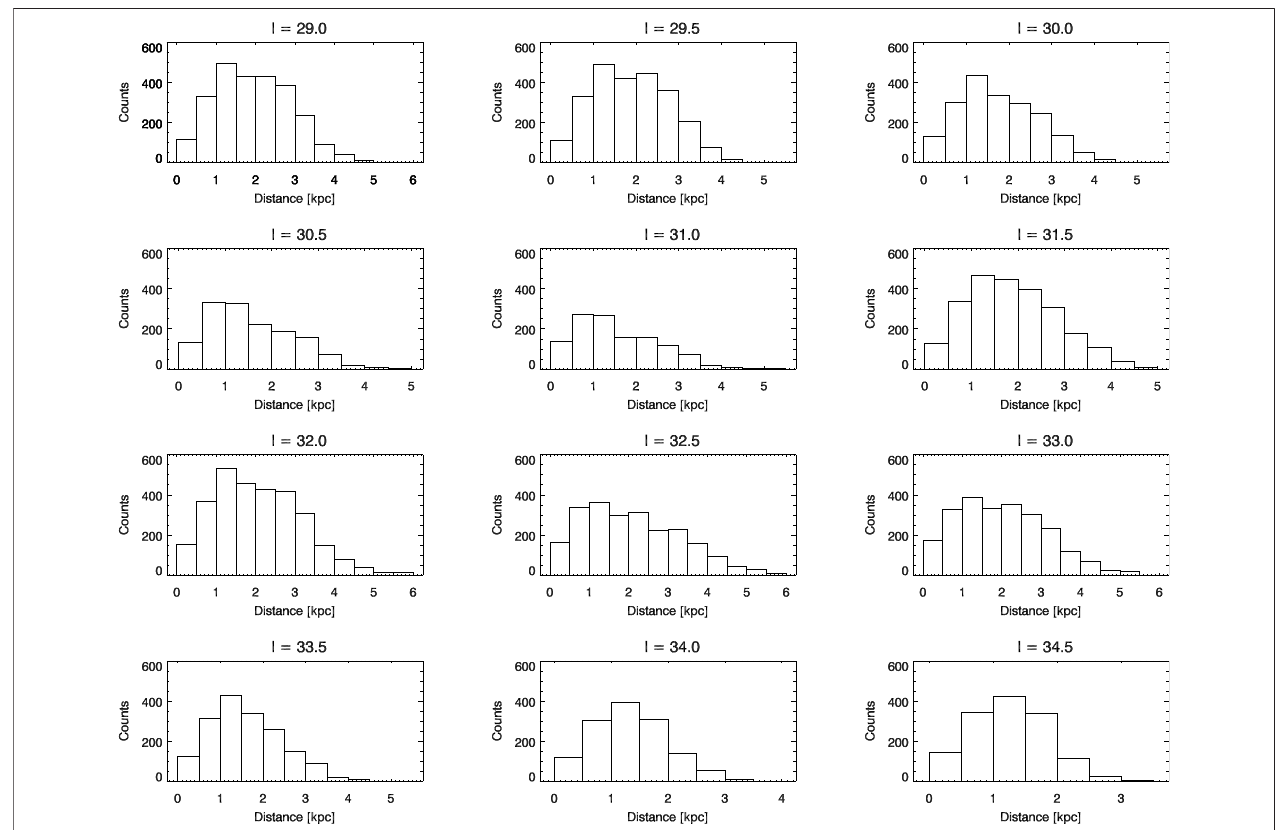
FIGURE 3 | Histograms of counts for distances (for | b | ≤ 0.5 o ) in Gaia-EDR3. The Galactic longitudes ( ± 0.250) are shown in the title of each panel.